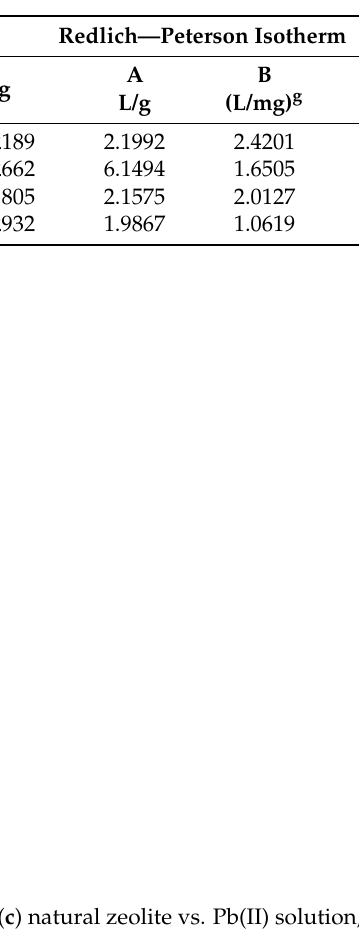
Figure 6. Experimental adsorption isotherms at 23 ◦ C for ( a ) MnOx-zeolite vs. Pb(II) solution, ( b ) FeO(OH)-MnOx-zeolite vs. Pb(II) solution, ( c ) natural zeolite vs. Pb(II) solution, and ( d ) FeO(OH)-zeolite vs. Pb(II)